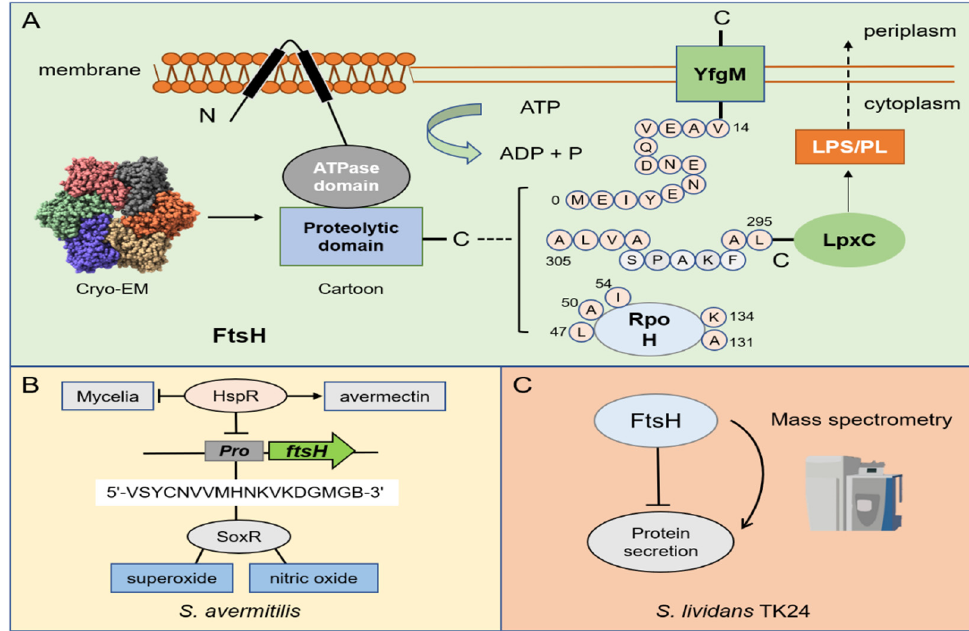
Figure 3. Overview of the degradation mechanism of FtsH protease and its regulation on metabolism. ( A ) The cartoon structure of FtsH protease and its Cryo—EM structure of the cytoplasmic domain from E . coli (The Cryo—EM structure was downloaded from PDB database). ( B ) Three kinds of substrates (RpoH, YfgM, and LpxC) of FtsH protease. The pink sphere represents the key amino acid in the degradation process. ( B ) In S. avermitilis , HspR can bind to ftsHp to inhibit FtsH and negatively regulate its development. SoxR can specifically bind to ftsHp to mediate the resistance of superoxide and nitric oxide by recognizing 18-nt binding site (5 (cid:48) -VSYCNVVMHNKVKDGMGB-3 (cid:48) ). ( C ) FtsH negatively regulates the protein secretion in S. lividans